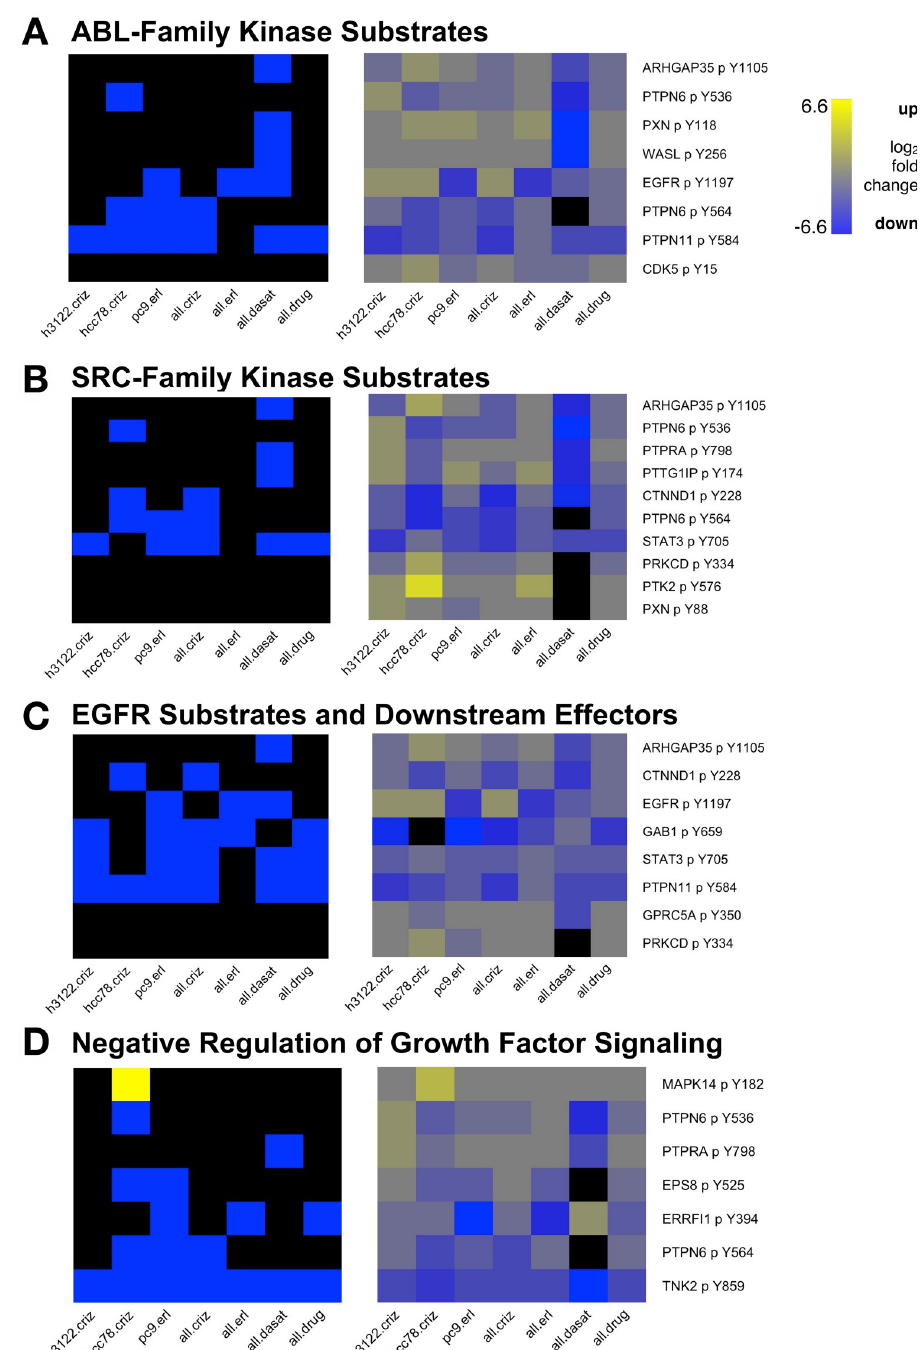
Fig 5. Heatmaps showing subsets of drug-affected phosphorylation sites in cluster A, grouped by cell signaling pathway. In the left hand panels, sites in cluster A whose median abundance ratio in drug-treated vs. control cells was at least 2.25-fold lower are blue and those that were at least 2.25-fold higher are yellow (black is below threshold). The right hand panels show the drug-treated to control ratio (median of samples in each group) for each PTM site (see key at right; black represents missing data). (A) Sites known to be phosphorylated by ABL-family kinases. (B) Sites known to be phosphorylated by SRC-family kinases (SFKs). (C) Sites that are phosphorylated directly by EGFR or downstream of EGFR activation. (D) Sites involved in negative regulation of growth factor signaling. Sample groups: h3122.criz: H3122 cells treated with crizotinb; hcc78.criz: HCC78 cells treated with crizotinib; pc9.erl: PC9 cells treated with erlotinib; all.criz: H3122, HCC78, H2228, and STE1 cells treated with crizotinib; all.erl: PC9, HCC4006,